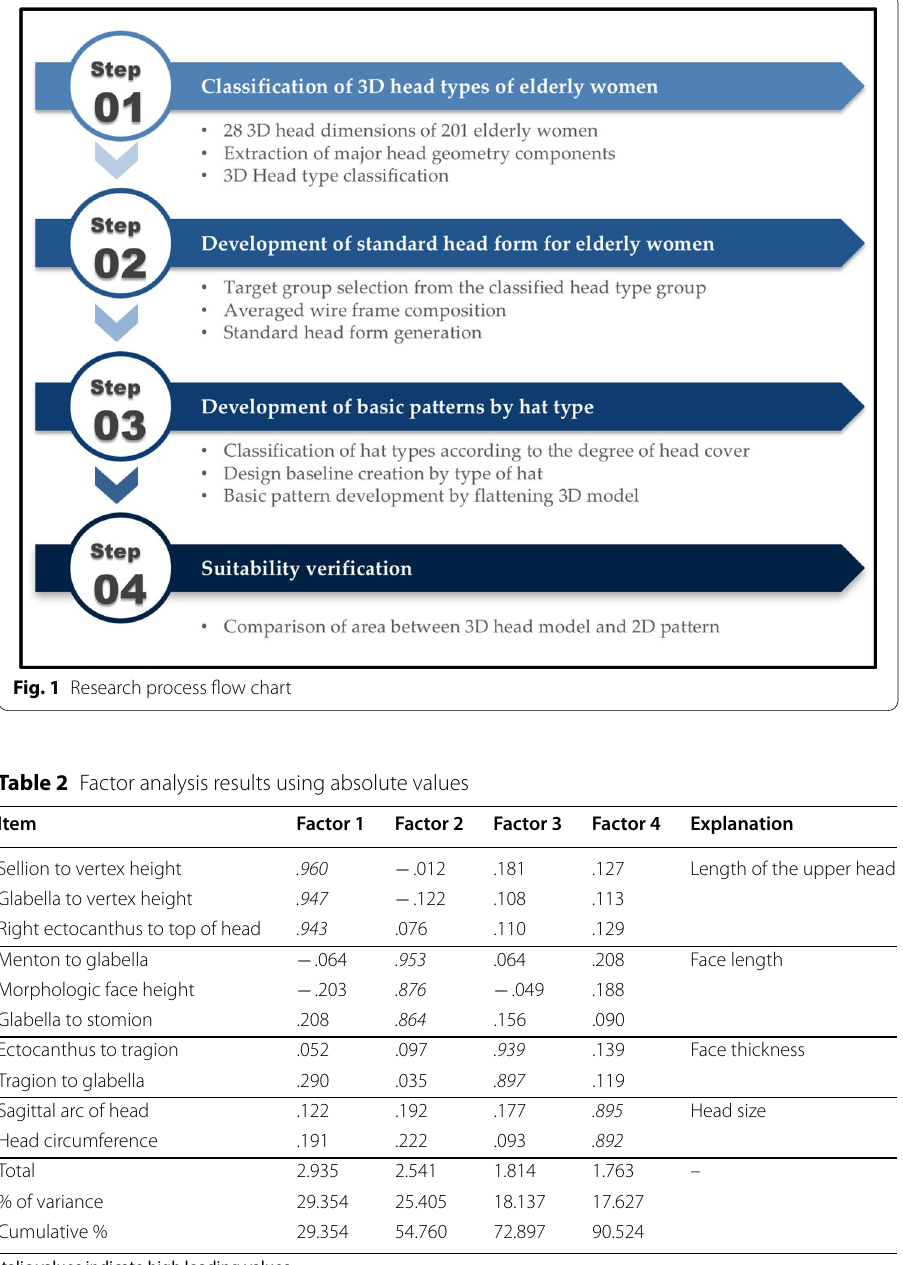
Italic values indicate high loading